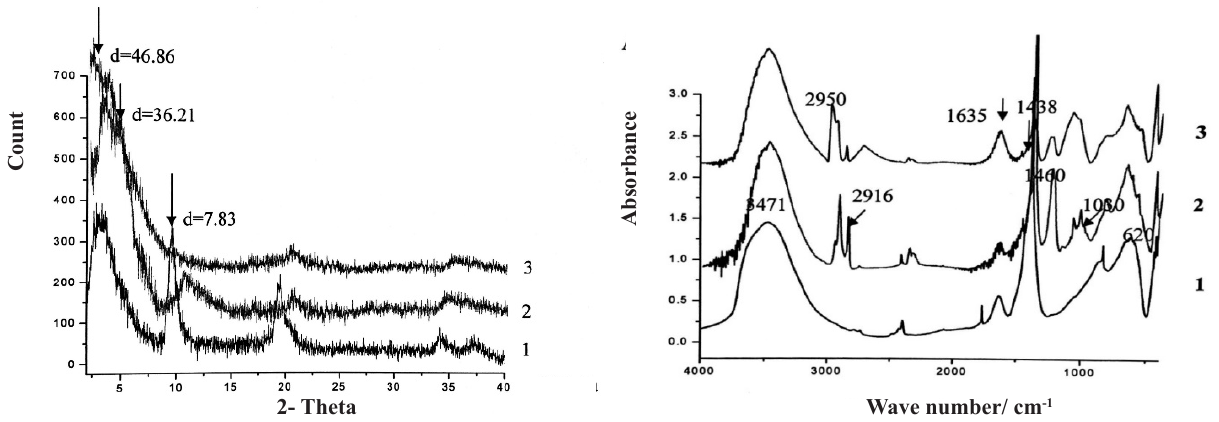
Figure 2.b: FTIR spectra of (1) Mg/ Al NO 3- LDH (2) Mg/ Al